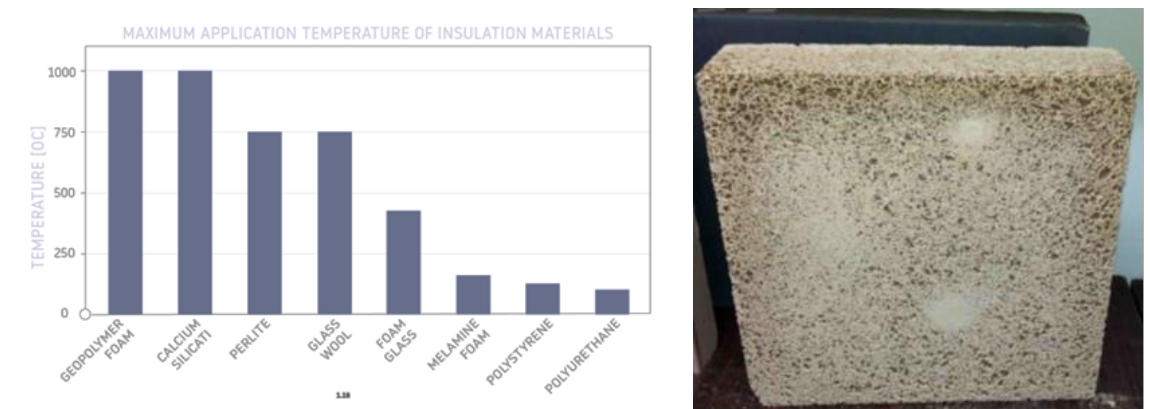
Figure 3. Maximum application temperature of some insulation materials, adapted from [12] and an example of foamed geopolymer panel (50 cm × 50 cm) (own research).